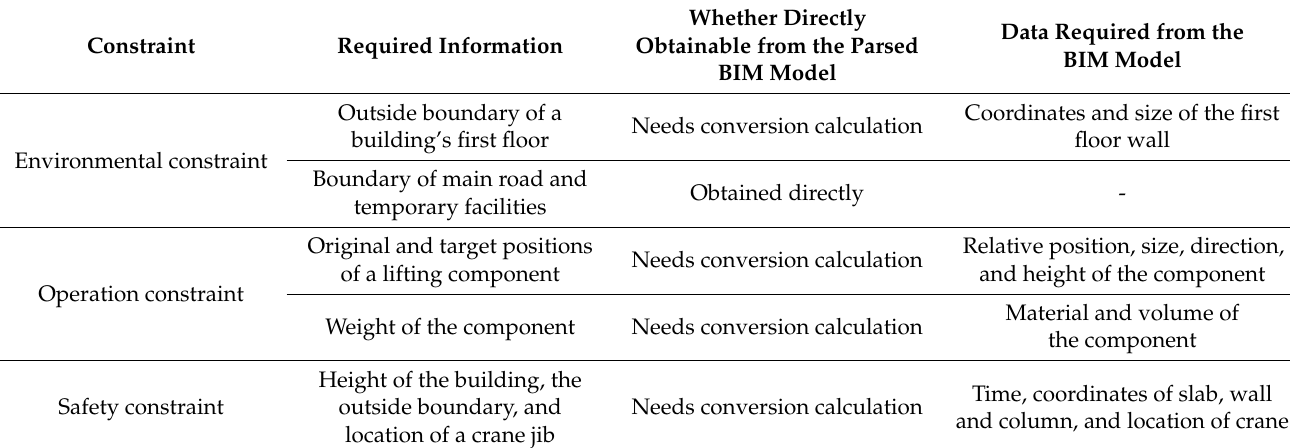
Table 2. Information required for the calculation of